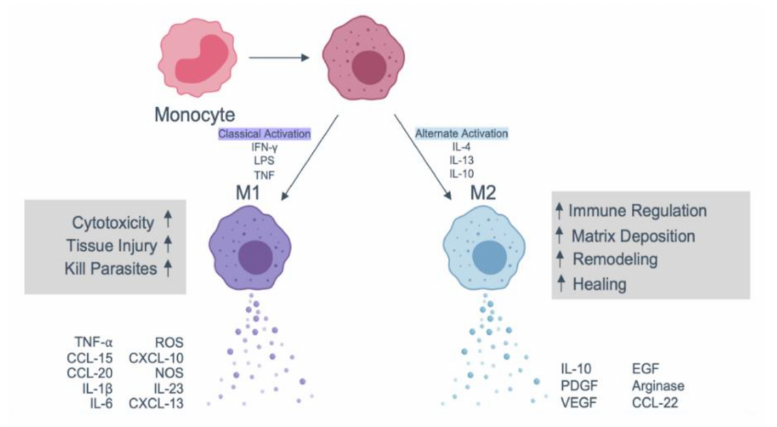
Figure 6. Schematic showing macrophage polarisation . The process is triggered during macrophage activation and polarisation into M1 and M2 subtypes and the subsequent cytokines and chemokines released by these cells. Adapted with permission from [53].